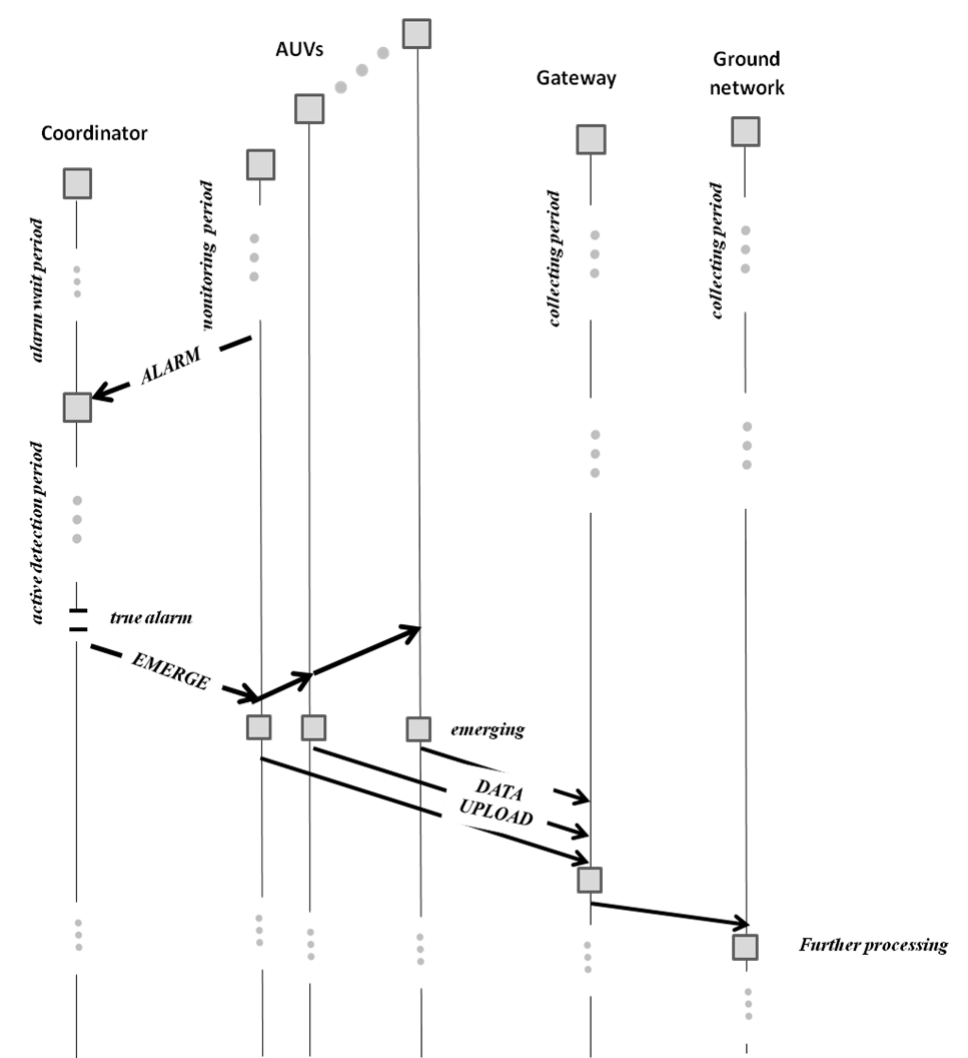
Figure 4. Protocol actions among